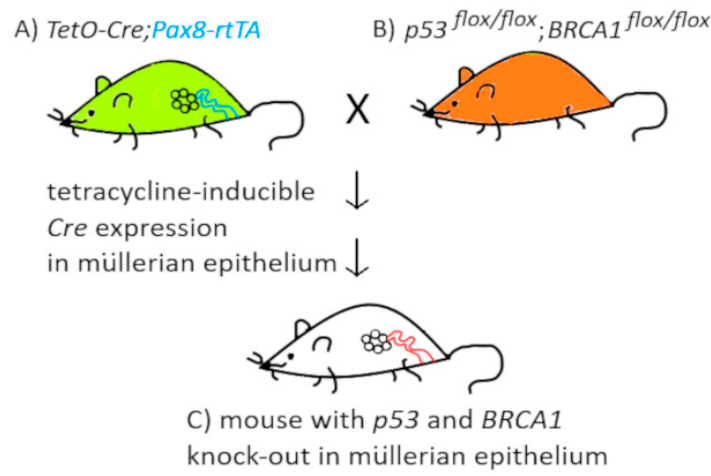
Figure 4. Mouse model used by Perets et al. [73] for the tissue-specific knock-out of the p53 and Brca1 genes, using Cre recombinase, the expression of which was limited to the Müllerian epithelia and induced after administration of the tetracycline.